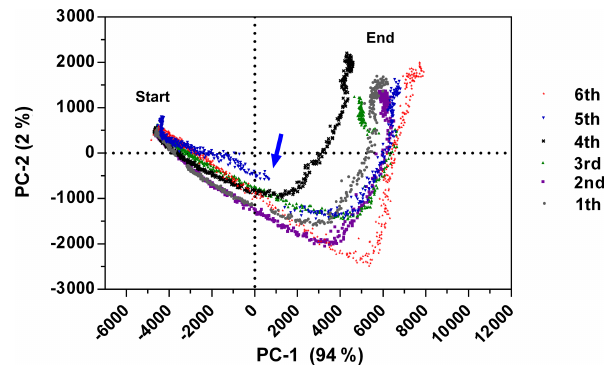
Figure 4. PCA on the fluorescence data showing the process tra- jectory and batch-to-batch variability of six E. coli K1 cultivations. The arrow marks the anti-foam addition in cultivation